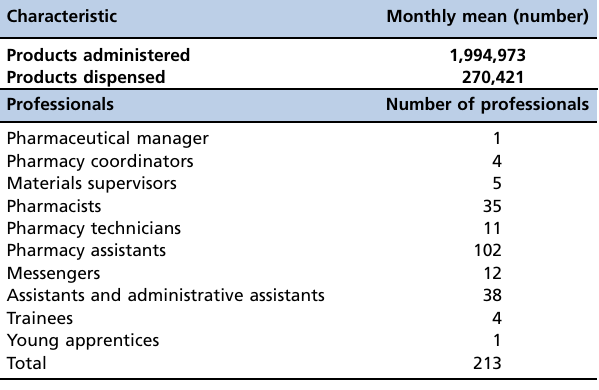
Table 1 - Characterization of the Central Pharmacy of Hospital Sı´rio-Libaneˆs regarding the products administered and dispensed as well as the number of staff. 2013. Sa˜o Paulo,